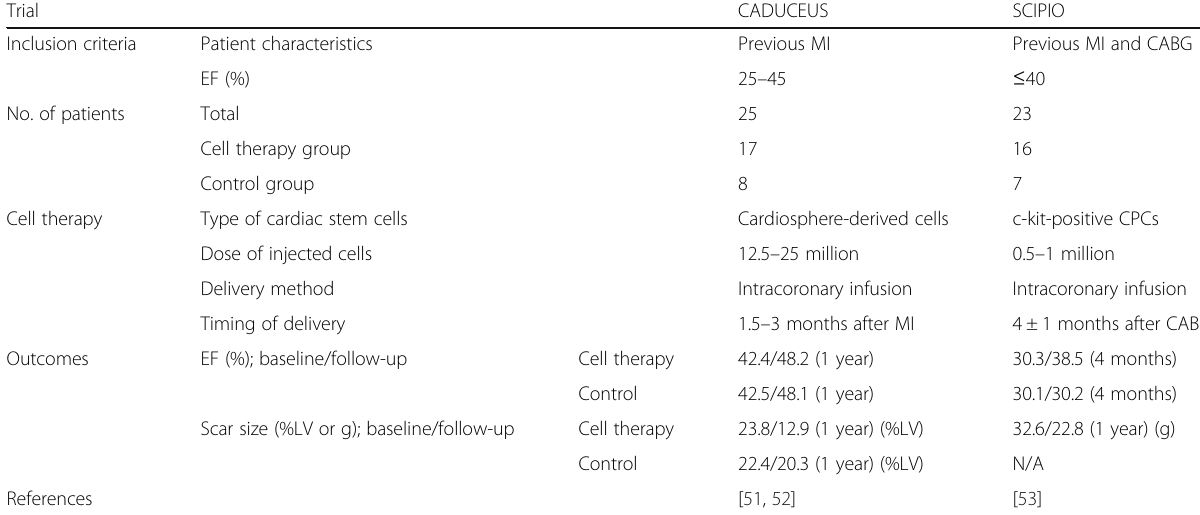
Table 1 Clinical trials using cardiac stem cells Trial CADUCEUS Inclusion criteria Patient characteristics No. of patients